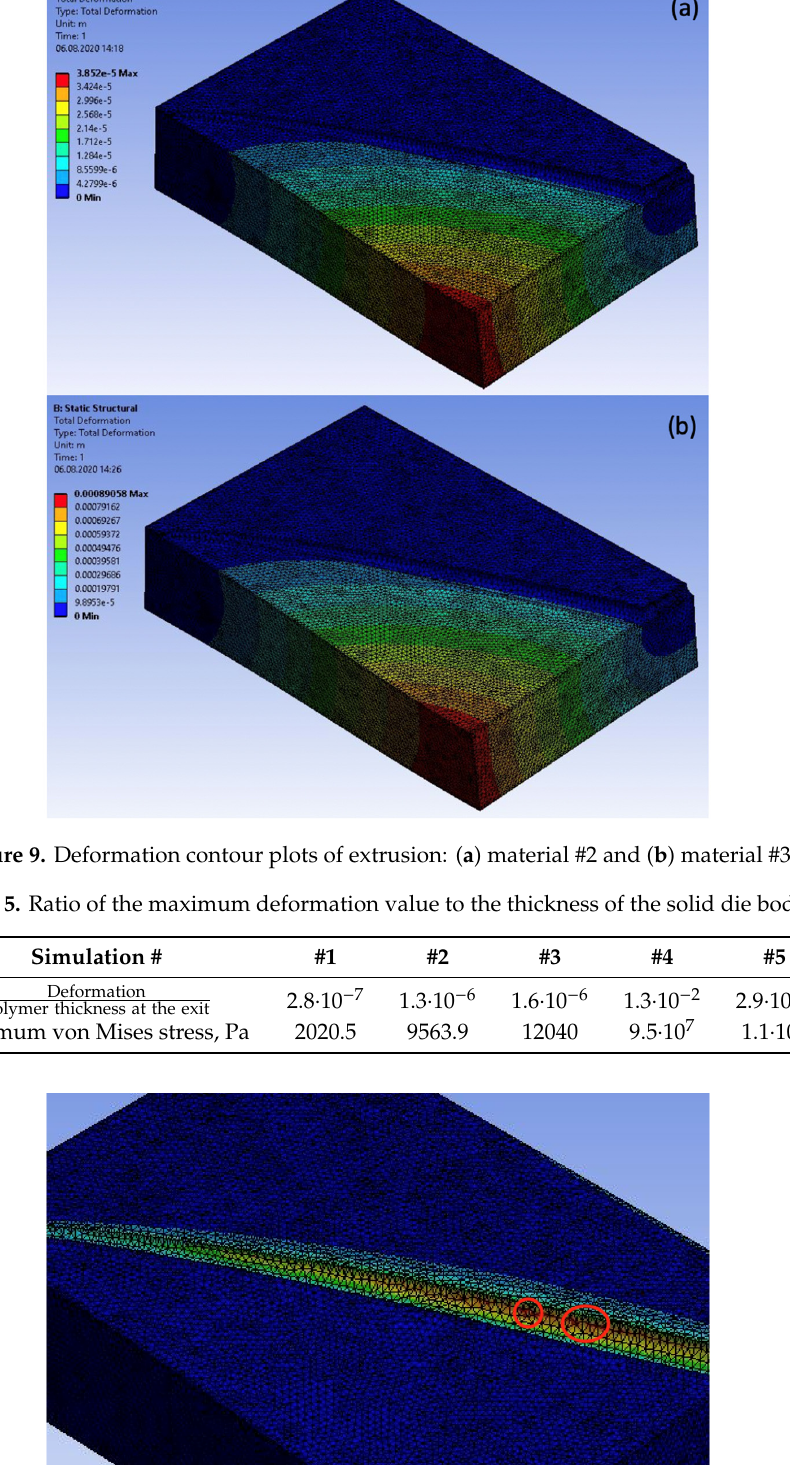
Figure 10. High stress elements: material #3.